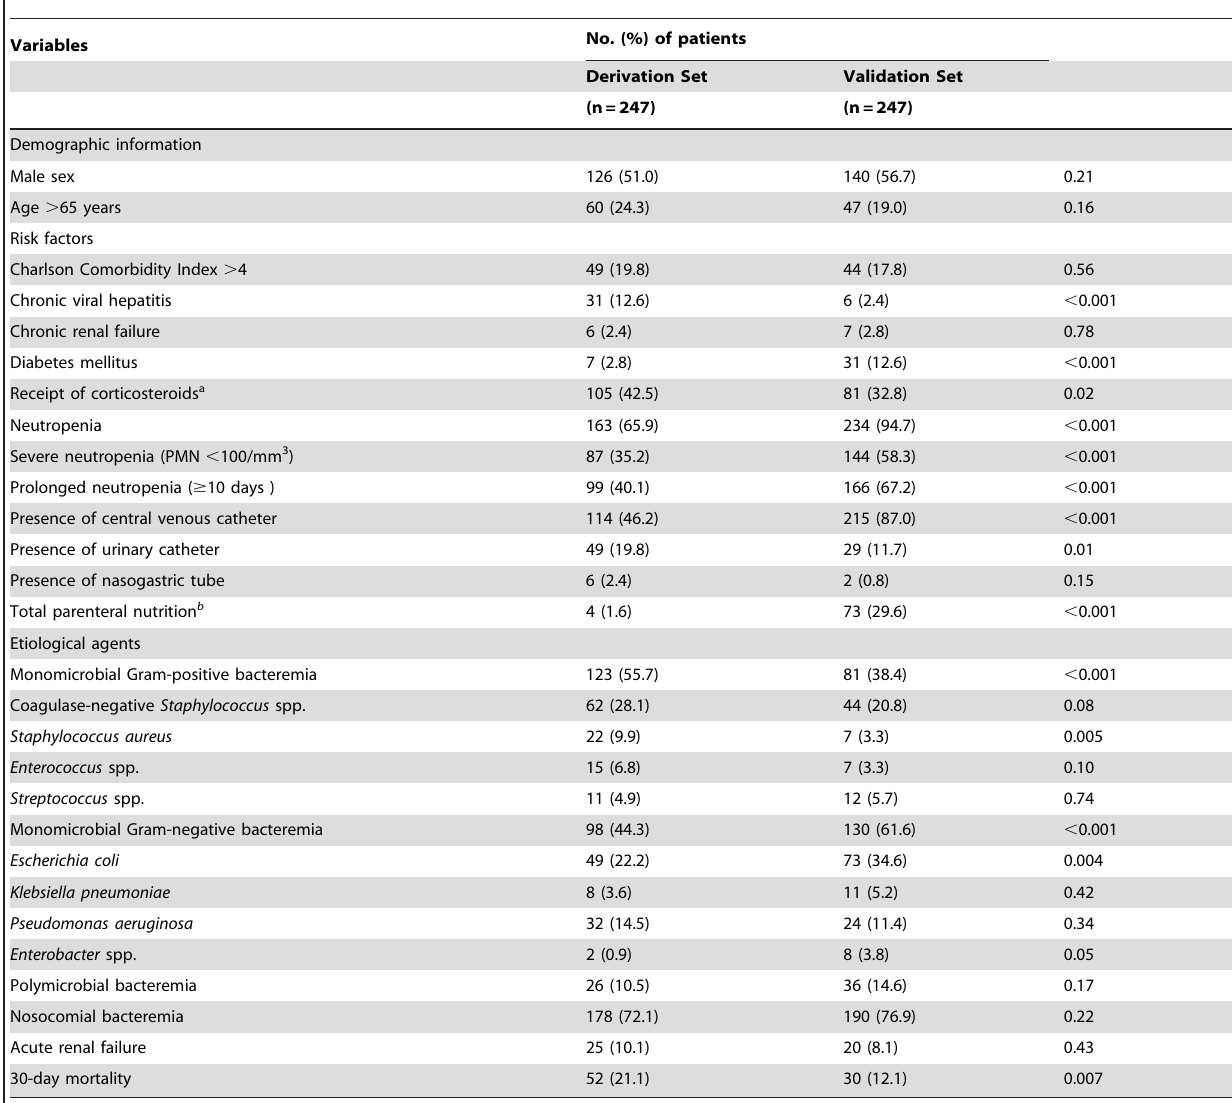
Table 1. Comparison of characteristics of case patients in the derivation and validation groups.